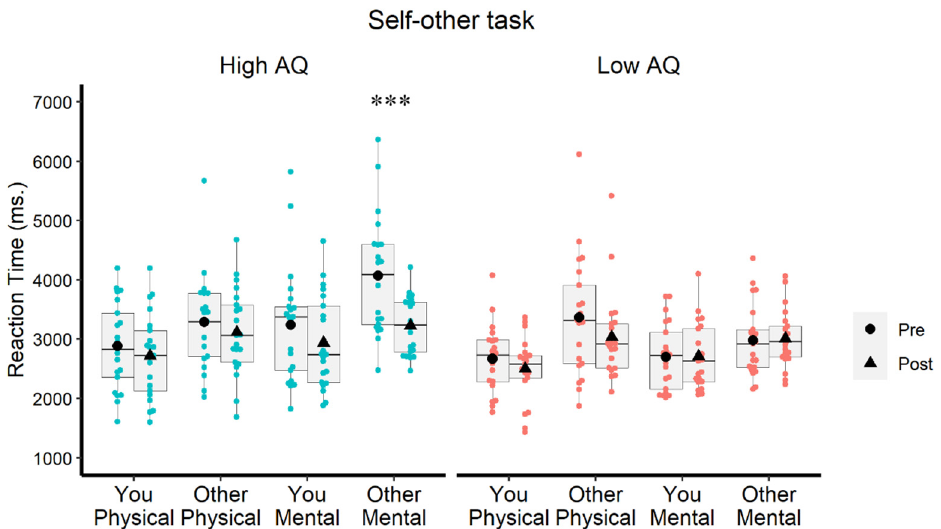
Figure 5. Reaction times in the self-other task in the high-AQ group ( left ) and the low-AQ group ( right ) as a function of Test (pre-post-tDCS), Reference (you, other) and Feature (physical, mental). Only significant effects of test are signaled (*** p < 0.0001).